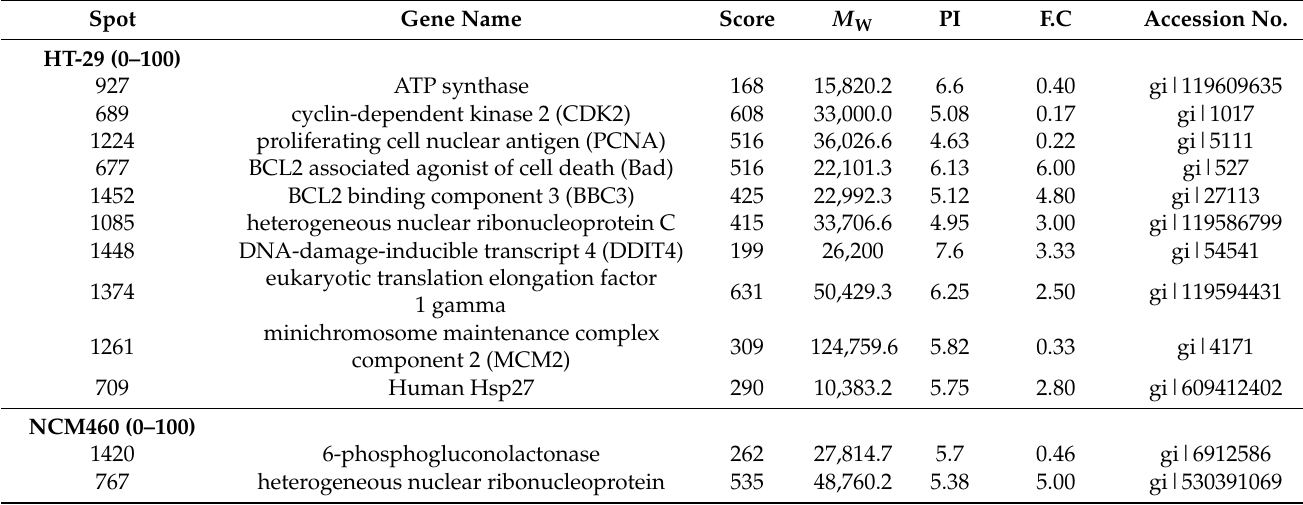
Table 1. Identification of differentially expressed proteins of SCS treatment in HT-29/NCM460.